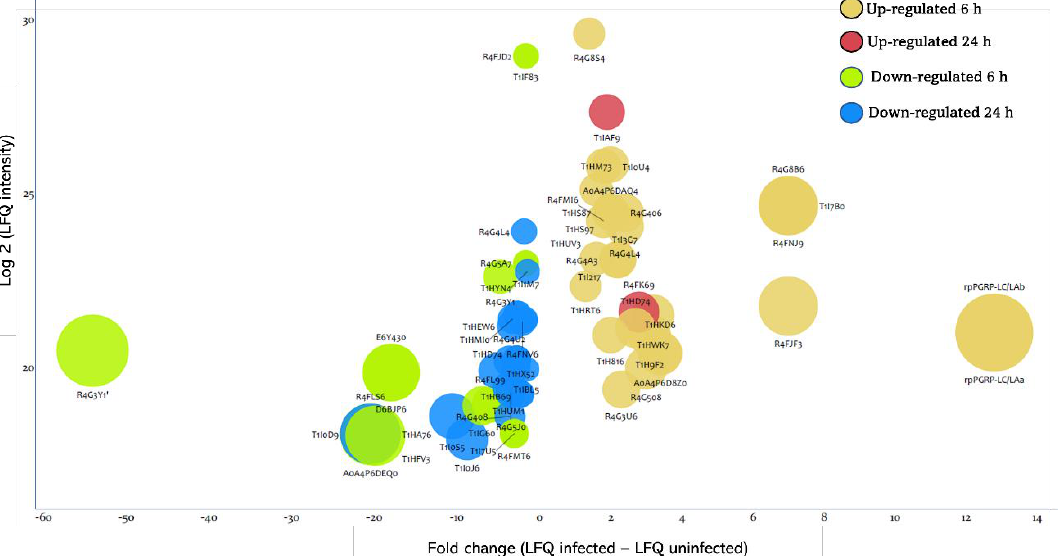
Figure 4. Bubble chart showing the differentially expressed proteins in R. prolixus hemolymph at 6 h and 24 h post- T. cruzi infection. Each bubble corresponds to a differentially expressed protein. x axis represents the fold change of protein expression, which is proportional to the bubbles size. y axis represents the log values of the intensity of protein expression.